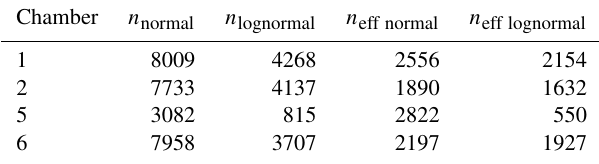
Table C1. Number of unflagged observations and number of effective records after accounting for autocorrelation in residuals.